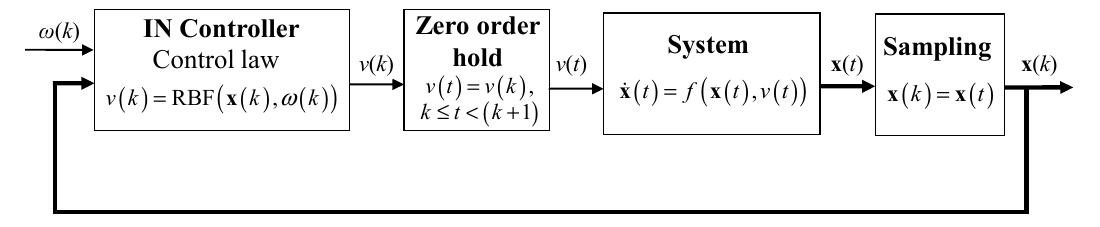
Figure 2. Closed loop with a simple RBF IN control scheme.